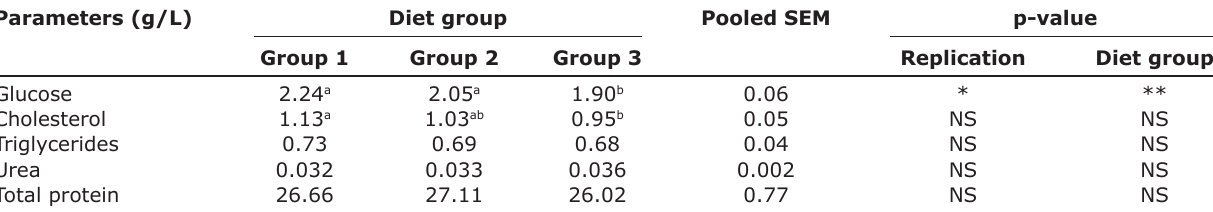
Table-3: Effect of Artemisia or olive leaf powder on selected serum biochemical parameters of broilers (mean, pooled SEM). Parameters